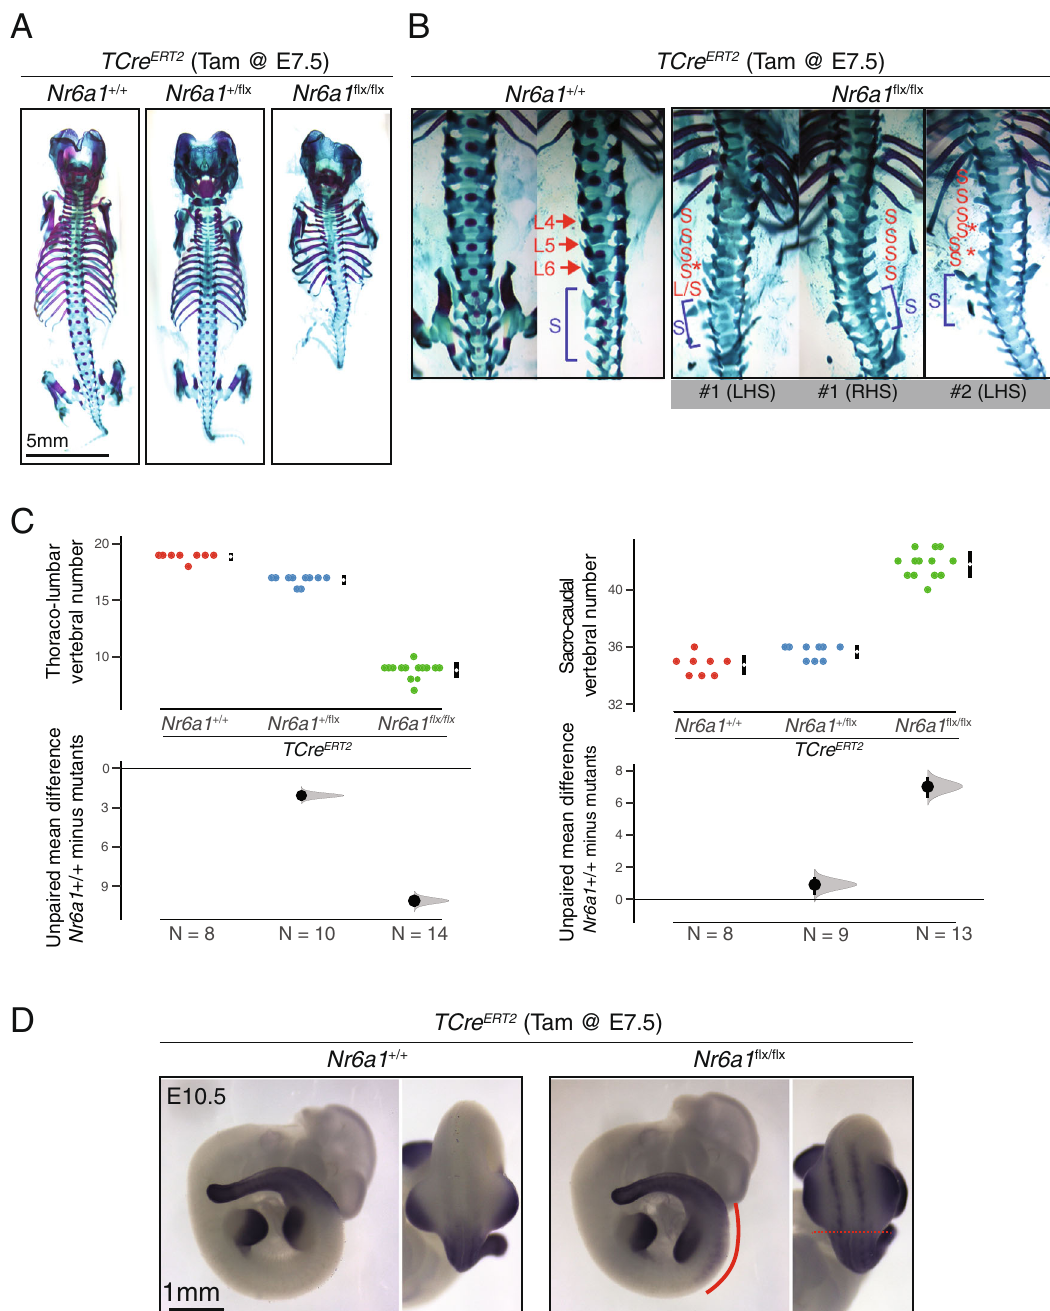
Fig. 2 | Nr6a1 is required for trunk elongation and timely activation of sacro- caudal identity. A Skeletal preparation of E18.5 embryos following conditional deletion of Nr6a1 revealed a dose-dependent reduction in the number of thoraco- lumbar elements. The number of biologically independent samples assessed: Nr6a1 +/+ n =8; Nr6a1 +/ − n =10; Nr6a1 − / − n =14. B In WT skeletons, removal of pelvic bones allowed visualisation of transverse process morphology characteristic of lumbar (L) and sacral (blue S) elements. In two representative TCre ER T2 ; Nr6a1 fl x/ fl x embryos, positioning of the normal sacral region is de fi ned by the presence of rudimentary pelvic bones (blue S) and lumbar elements that have assumed sacral identitymarked(redS).Redasteriskindicateslateralfusionsbetweentwoadjacent elements. LHS=left-hand side; RHS=right-hand side. C Quanti fi cation of thoraco- lumbarandsacro-caudalvertebral numberfollowing conditionaldeletion of Nr6a1